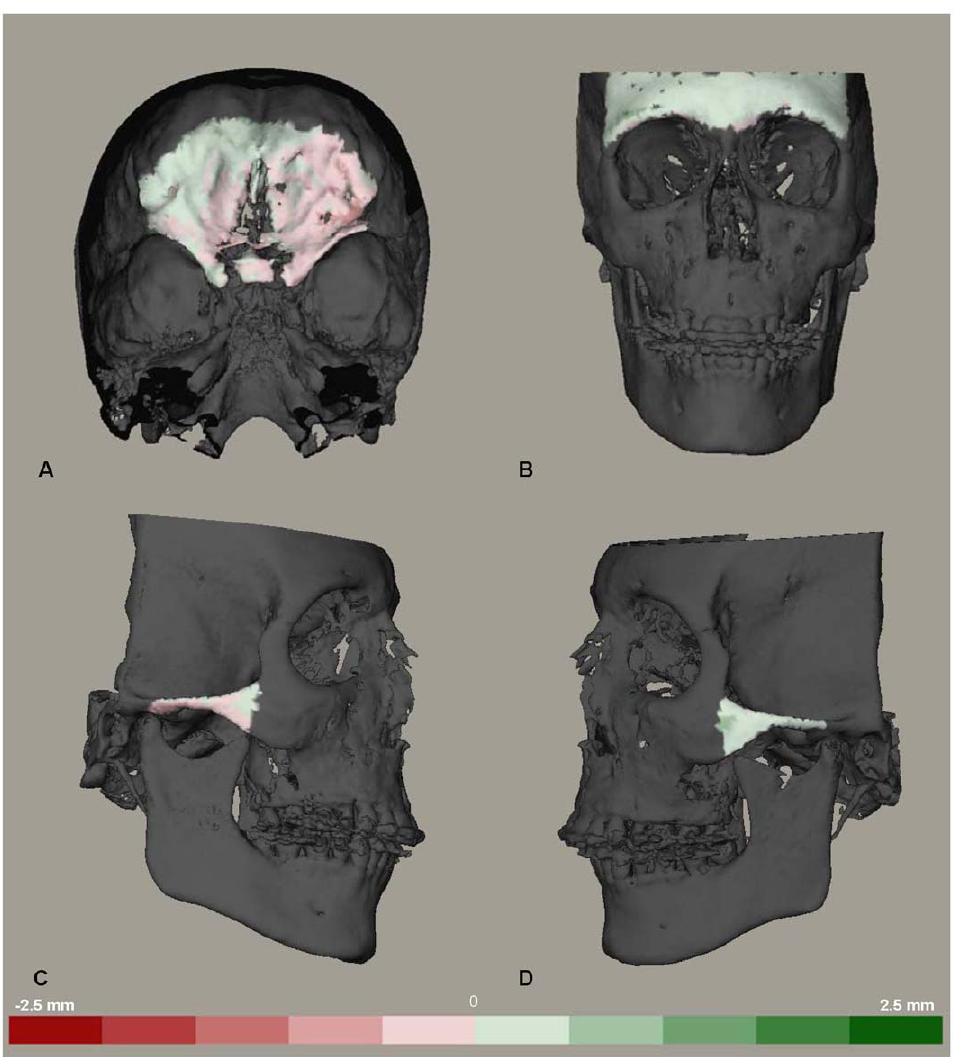
Figure 7. Distance maps to visualize the distances between two models registered on the left zygomatic arch. Color coded distance maps to visualize the distances between two superimposed models registered on the left zygomatic arch. The green color indicates that the superimposed model is in front of the original model and red color indicates the opposite. Each color graduation is 0.5 mm. (A) anterior cranial base. (B) the forehead region. (C) the right zygomatic arch. (D) the left zygomatic arch.